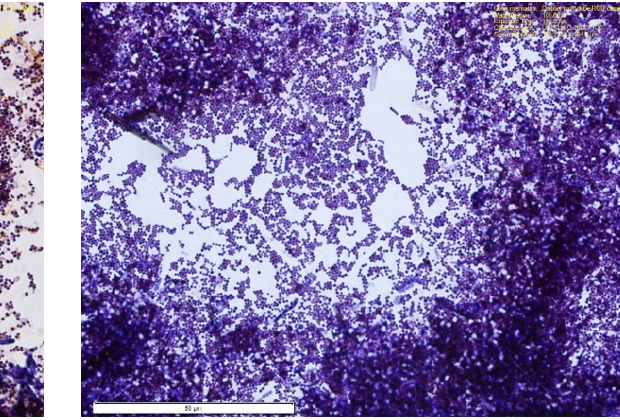
Figure 13. Airborne contaminant collection on PCL fiber cloth indicated with red arrows.